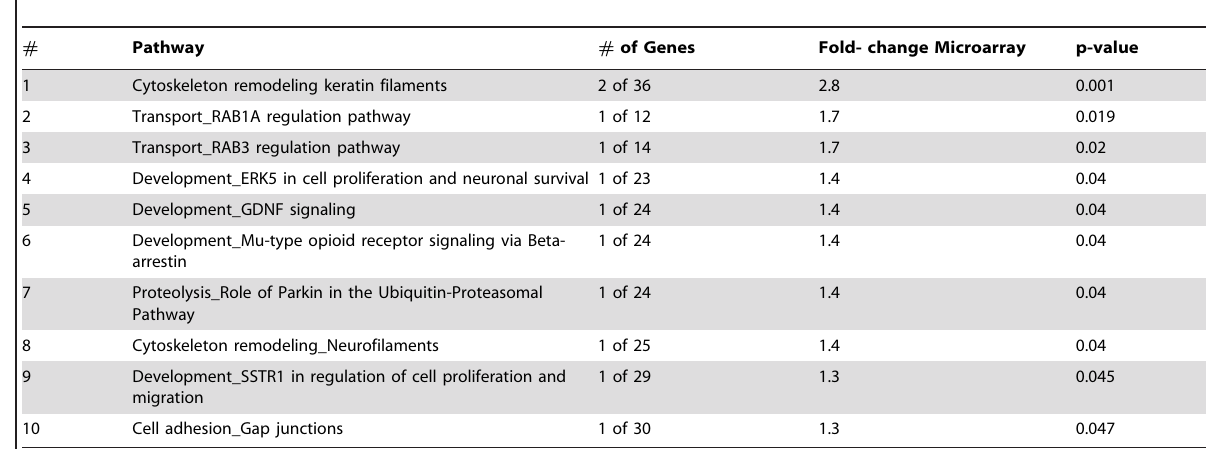
Table 3. Molecular pathways affected by exposure to PTU in E10.5 embryos.